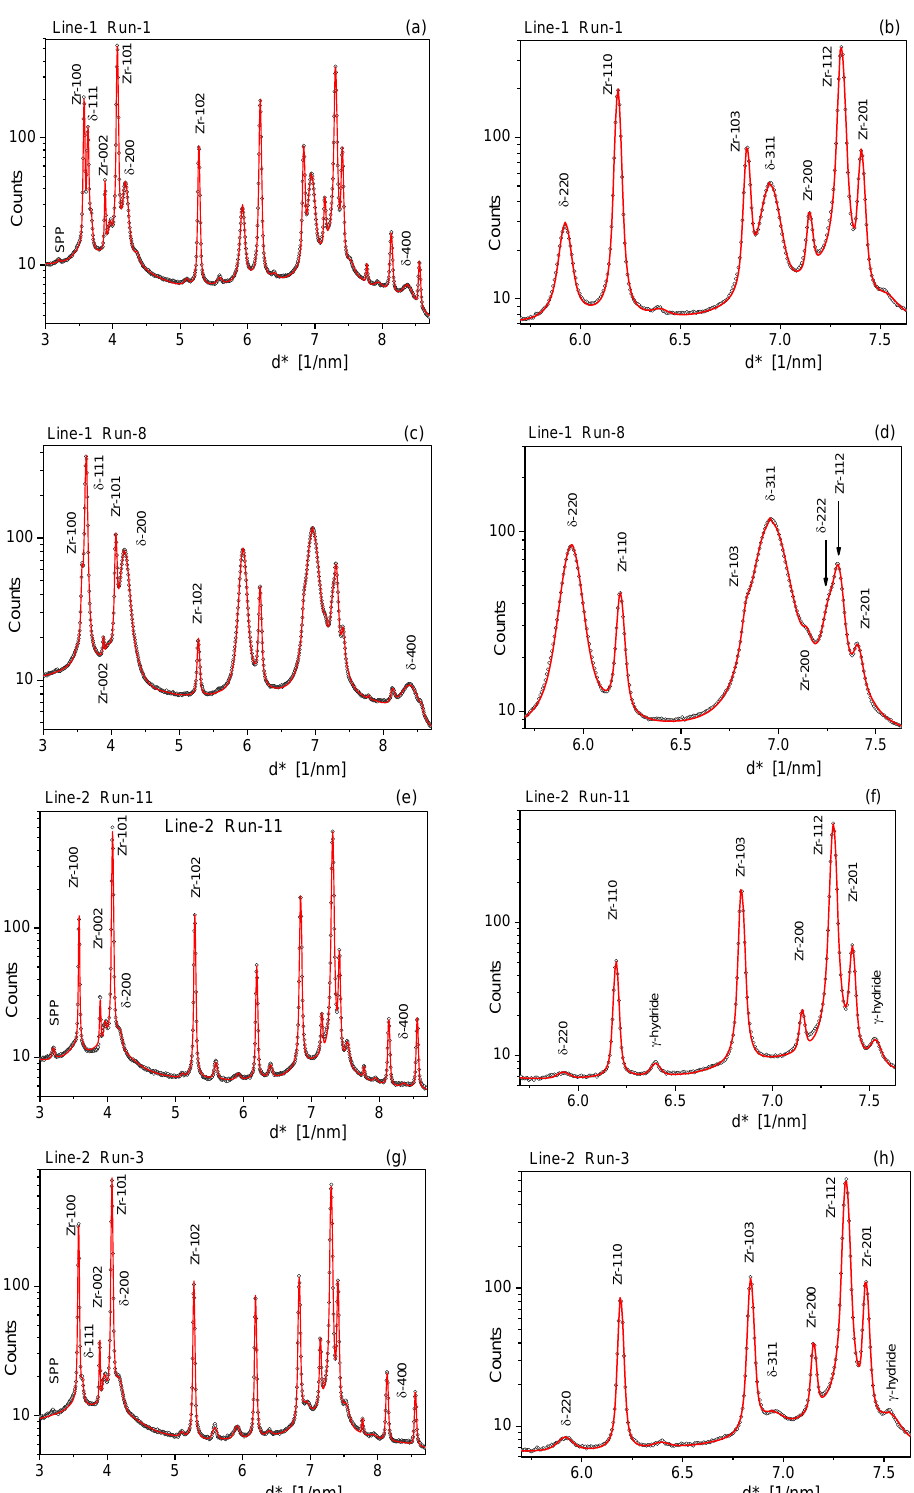
Figure 9. Measured (open circles) and CMWP-calculated (red lines) di ff raction patterns ( a , c , e , g ) in the entire, and ( b , d , f , h ) in a zoomed angular range at four di ff erent depths in the ZrH blister. ( a , b ) are along Line-1 Run-1 at the top right edge, ( c , d ) are along Line-1 Run-8 at the center, ( e , f ) are along Line-2 Run-11 at the lower center edge, and ( g , h ) are along Line-3 Run-3 at the right middle edge of the blister, respectively.